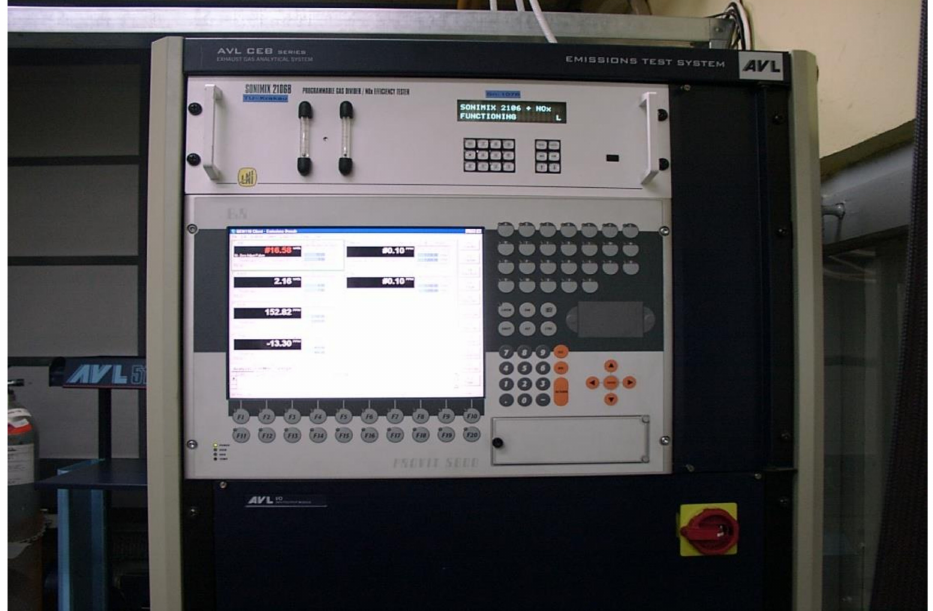
Figure 4. Front panel of the AVL CEBII measurement system.